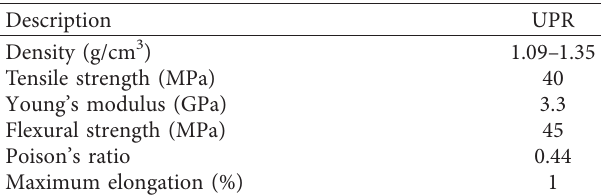
Table 4: Characteristics of UPR.